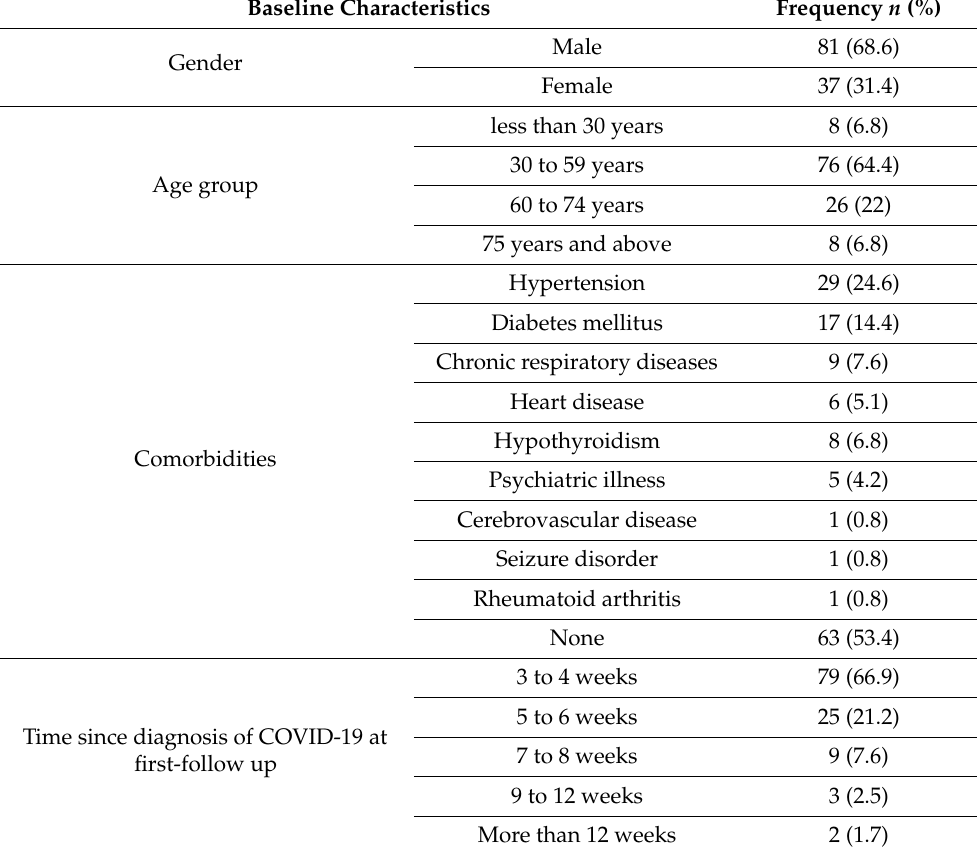
Table 1. Baseline characteristics of post-COVID-19 patients presenting to follow-up OPD at STIDH